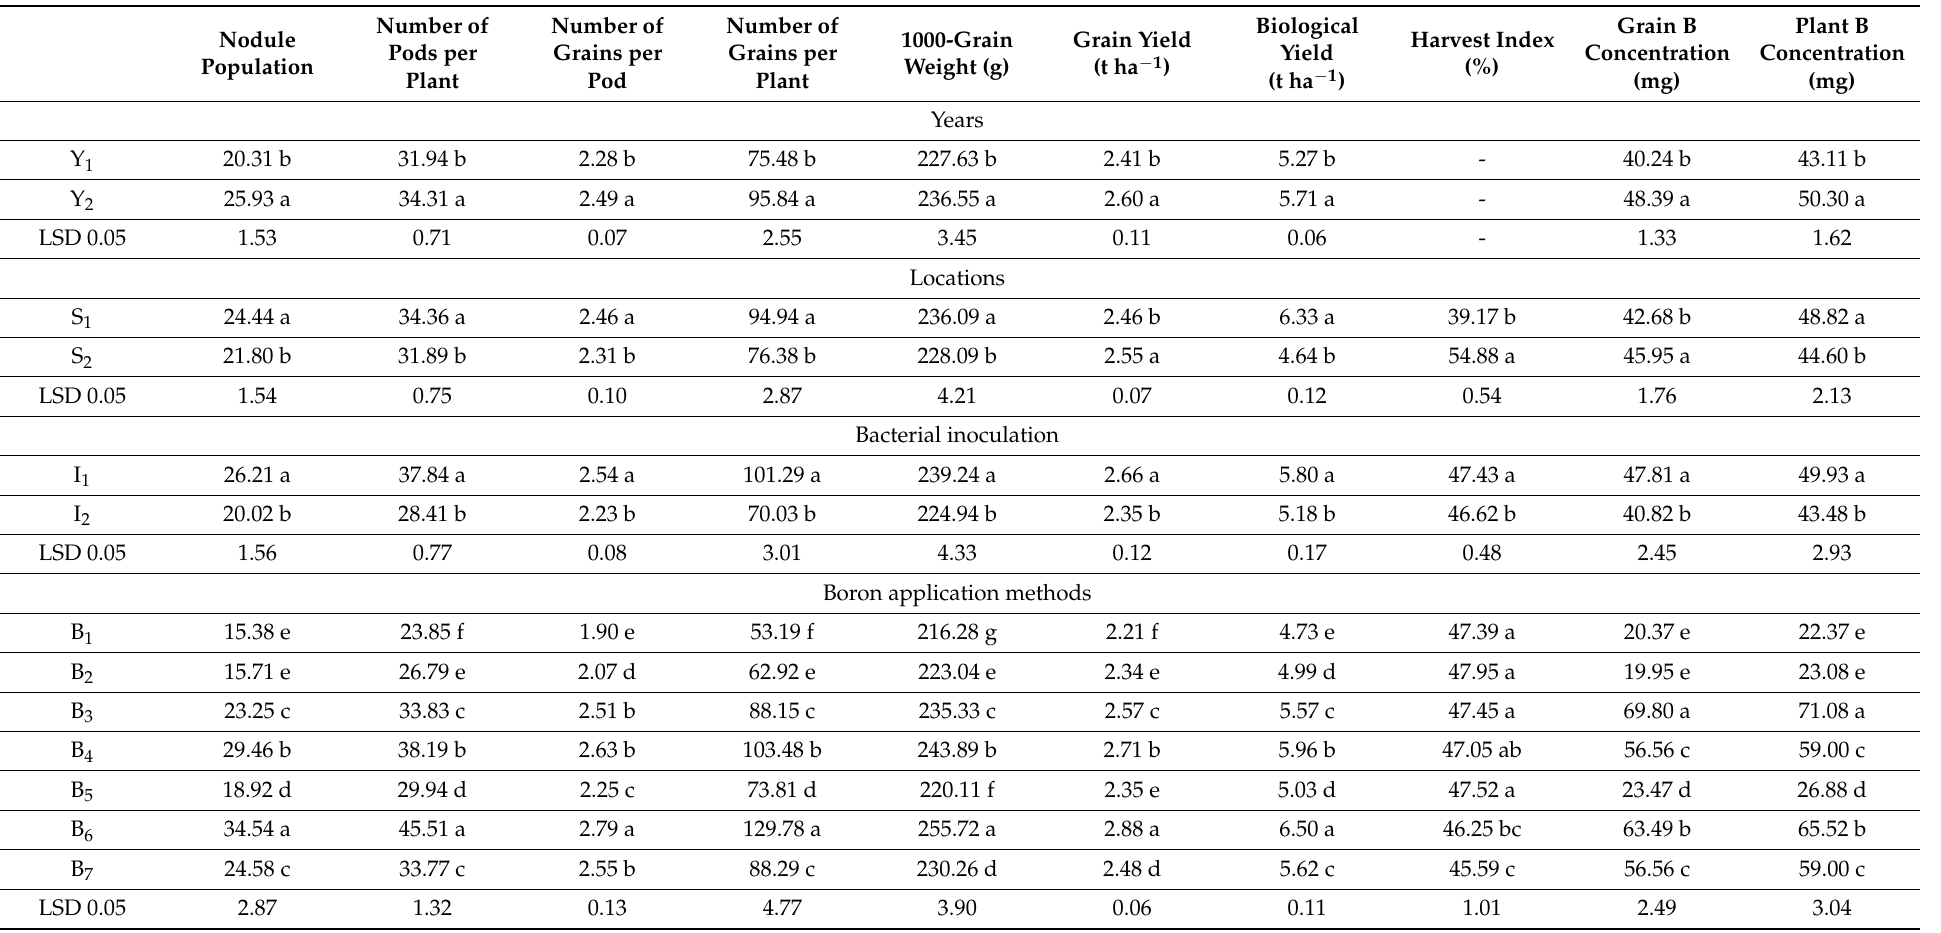
Table 3. The impact of year, location, BTB ( Bacillus sp. MN54) inoculation and boron nutrition on growth and yield-related traits of desi